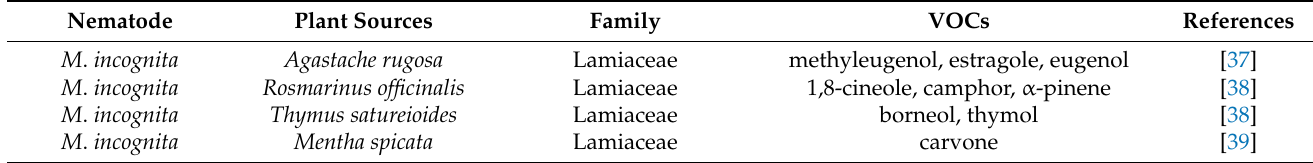
Table 2. VOCs produced by plants against Meloidogyne spp. and B. xylophilus . Nematode Plant